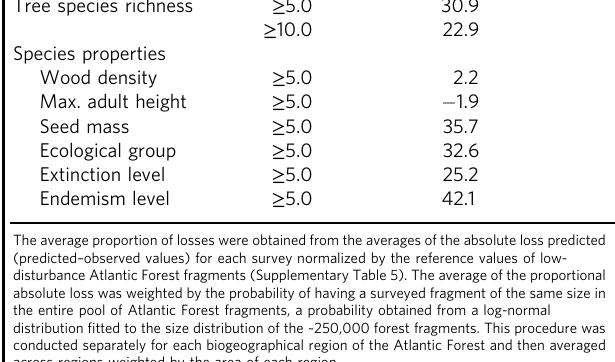
absolute loss was weighted by the probability of having a surveyed fragment of the same size in the entire pool of Atlantic Forest fragments, a probability obtained from a log-normal distribution fi tted to the size distribution of the ~250,000 forest fragments. This procedure was conducted separately for each biogeographical region of the Atlantic Forest and then averaged across regions weighted by the area of each